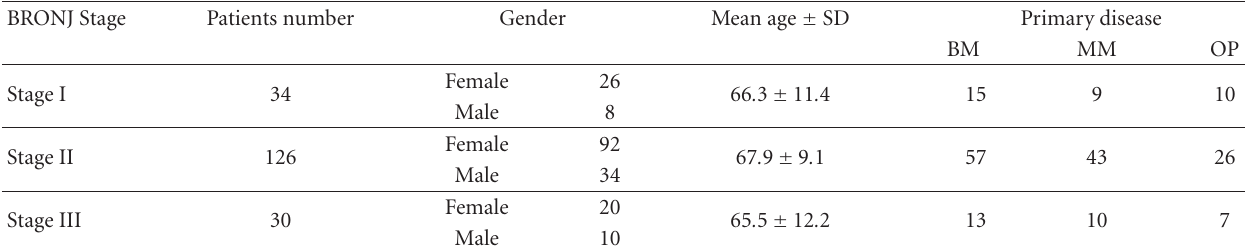
Table 1: Baseline data of patients: BRONJ stage according to Ruggero’s classification, gender distribution, age, and primary disease; BM: bone metastasis, MM: multiple myeloma, OP: osteoporosis and/or rheumatoid